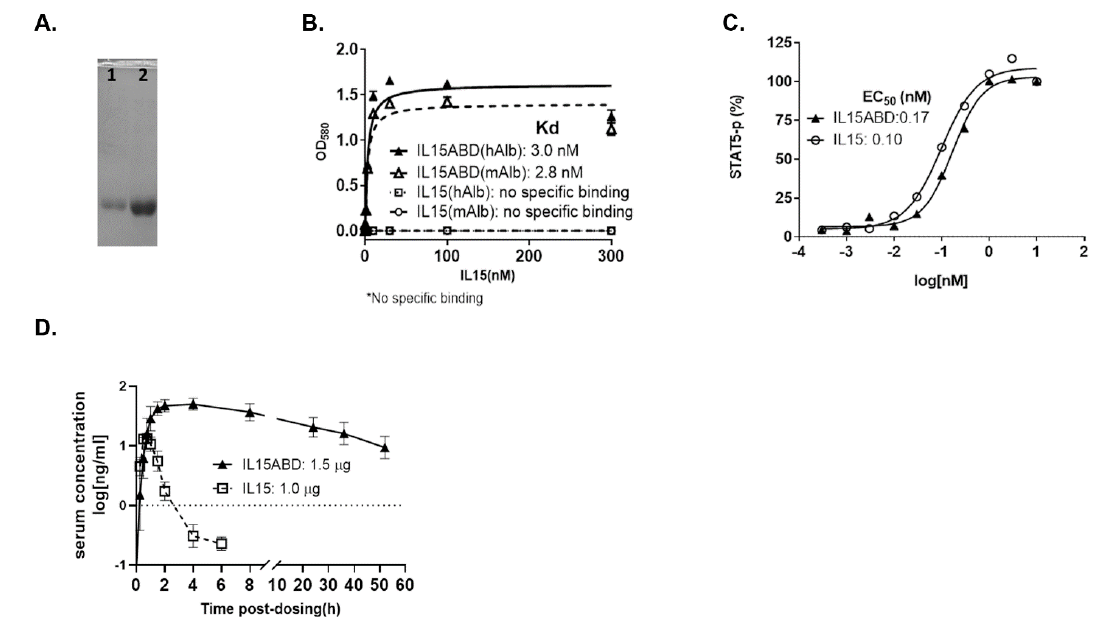
Figure 2. In vitro characterizations and pharmacokinetics of hIL15-ABD purified in large scale. ( A ) Lane 1 of the SDS-PAGE indicates the purified hIL1-ABD in refolding buffer number 26 (NaCl (250 mM), GSH (1 mM) and GSSG (0.1 mM) in Tris-HCl buffer (50 mM, pH 8.5)) and lane 2 represents hIL15-ABD after being condensed following the process of refolding. ( B ) Refolded purified hIL-15-ABD displays similar affinity for binding to both human and murine albumin, whereas there is no measurable specific binding to albumin by hIL15. ( C ) hIL15 and IL15-ABD demonstrate comparable EC50 values of stimulation of STAT-5 phosphorylation in CTLL-2 cells, which are 0.10 and 0.17 nM, respectively. ( D ) Serum concentration-time curves of hIL15 in Balb/c mice following single intraperitoneal injection of hIL15-ABD and hIL15 at 1.5 and 1.0 μg/mouse. Data are presented as mean ± SD. N = 3 at each time point.